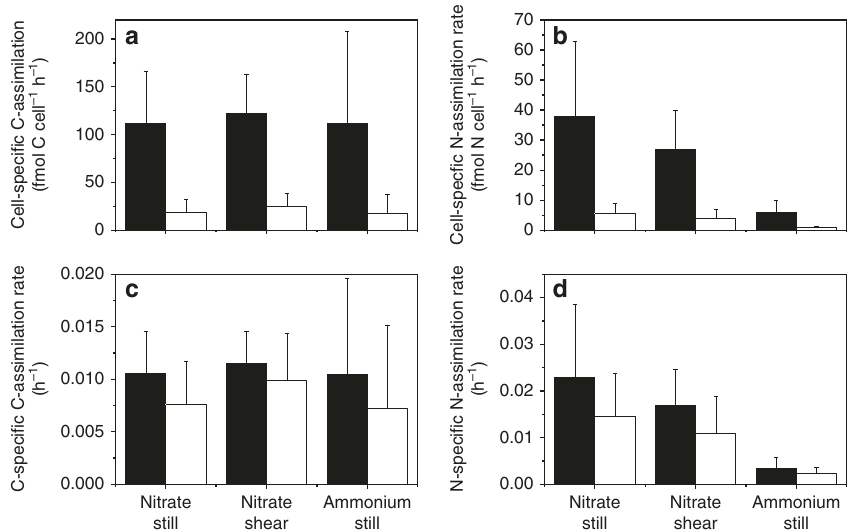
Fig. 5 C- and N-assimilation rates in the Skeletonema population and the Chaetoceros population. Cell-speci fi c C-assimilation rates ( a ); Cell-speci fi c N- assimilation rates ( b ); C-speci fi c C-assimilation rates ( c ) and N-speci fi c N-assimilation rates ( d ) in Chaetoceros (black bars) and Skeletonema (white bars) measured for nitrate as N sources and under still conditions or turbulent shear and at light intensities >200 μ mol photons m − 2 s − 1 . Ammonium assimilation rates were measured without turbulent shear and represent the average value in light and darkness. All values represent the average with one standard deviation ( n = 70 – 262). Statistically signi fi cant differences are described in the text